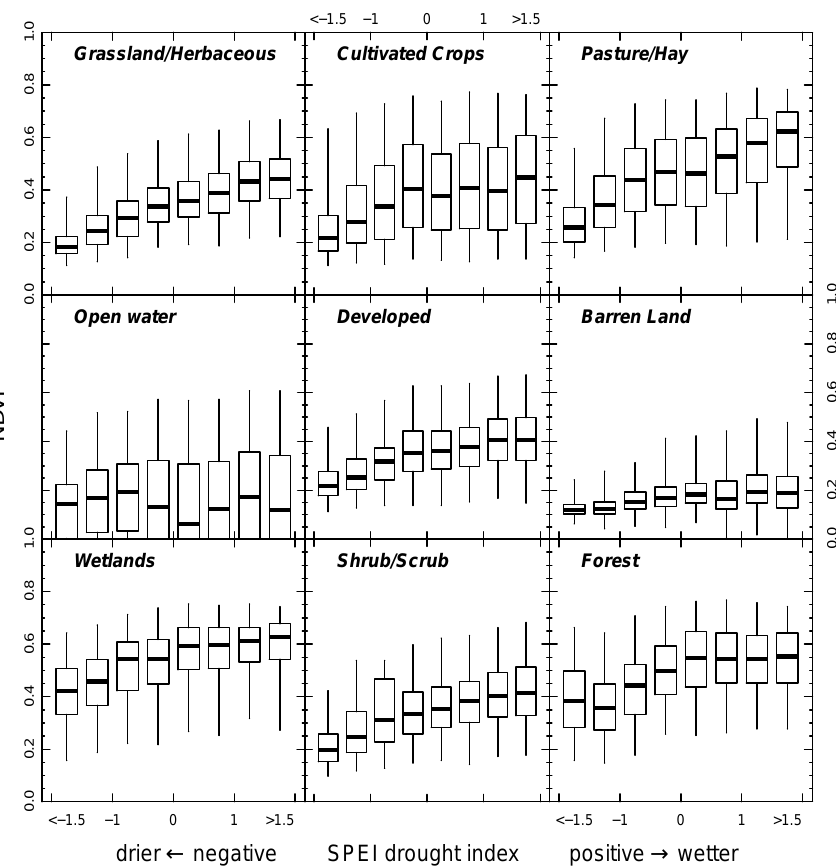
Figure 10. Similar to Figure 9, NDVI is shown to provide context to aid in the interpretation of